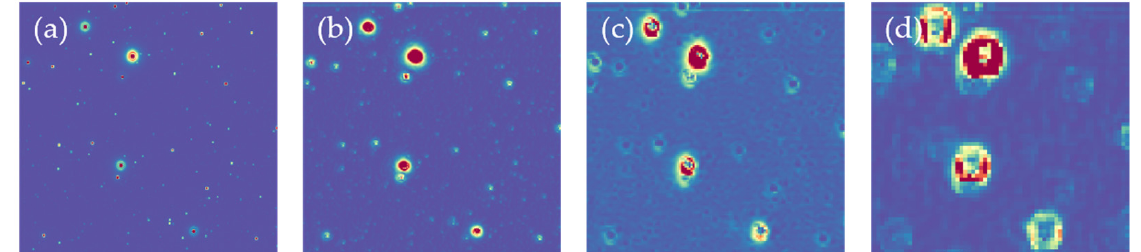
Figure 4. Changes in feature maps during down-sampling. ( a ) The feature map of the input image after convolution. ( b ) The feature map after the first down-sampling. ( c ) The feature map after the second down-sampling. ( d ) The feature map after the third down-sampling.